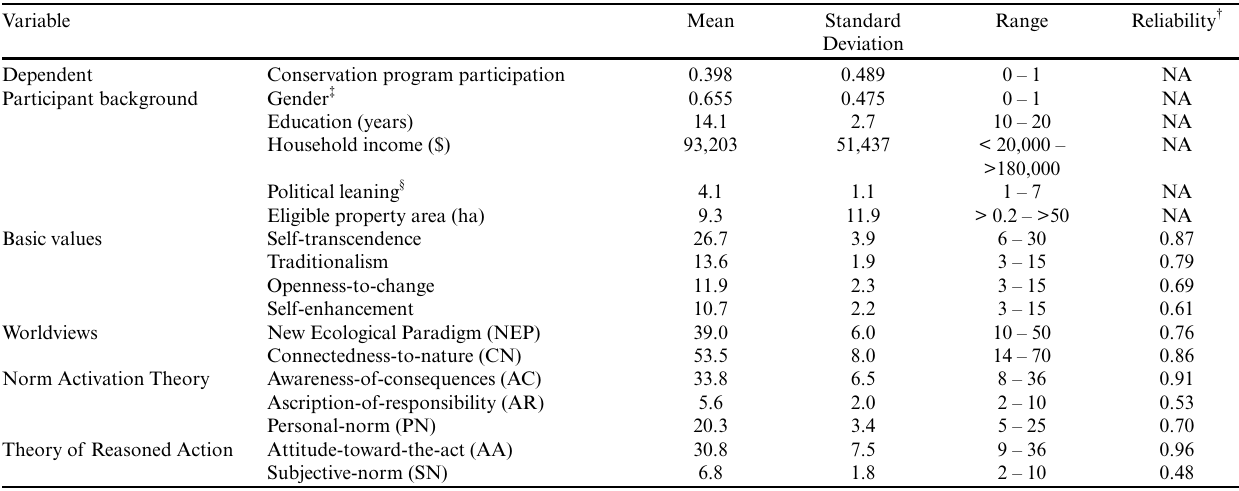
Table 1 . Descriptive statistics of study